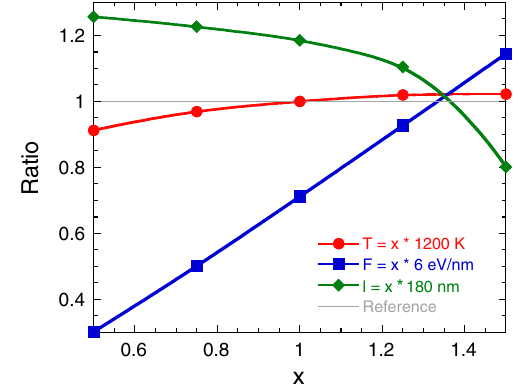
FIG. 16. Ratio of array emittances with reference cases ( ε T ¼ ref 17 . 0 mm-mrad; ε F ¼ 2 . 30 mm-mrad; ε ω ¼ 16 . 0 mm-mrad) ref ref as a function of the ratio of the independent parameter with 1200 K (thermal), F 6 eV = nm (field), and λ T scale ¼ scale ¼ scale ¼ 180 nm (photo). FIG. 17. Same as Fig. 3 but now the hemispherical boss sits atop a cylinder of the same length as the fibers shown in Fig. 1 (only the apex region is shown). The total current is 4 times larger and the emittance has increased by a factor of > 30 times.